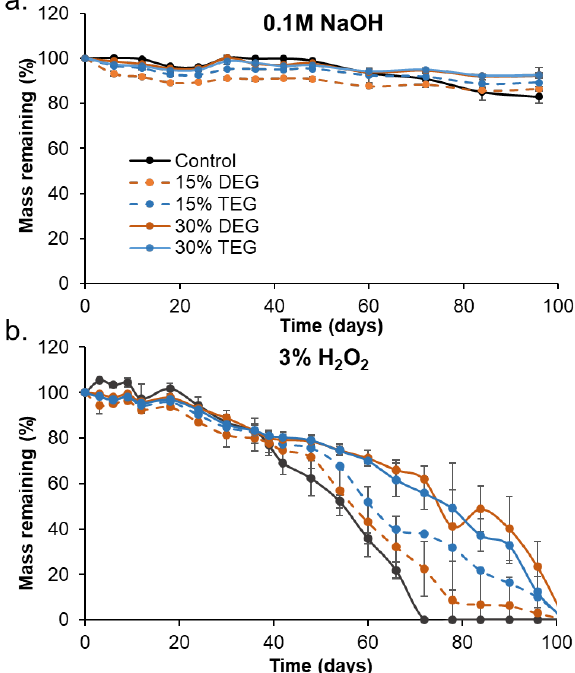
Figure 3. Mass loss profiles of samples as a function of time in ( a ) accelerated hydrolytic degradation media, 0.1 M NaOH, and ( b ) oxidative degradation media, 3% H 2 O 2 . n = 5, mean ± standard deviation displayed. Legend provided in ( a ) applies to both charts.